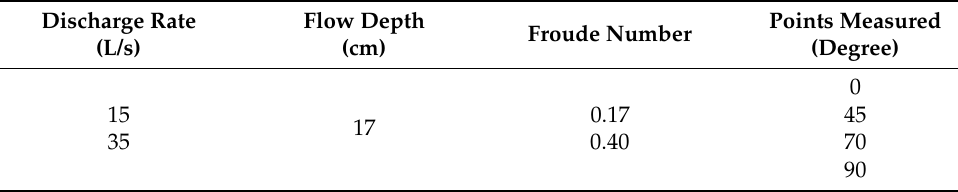
Table 1. Test programs of this research based on flow